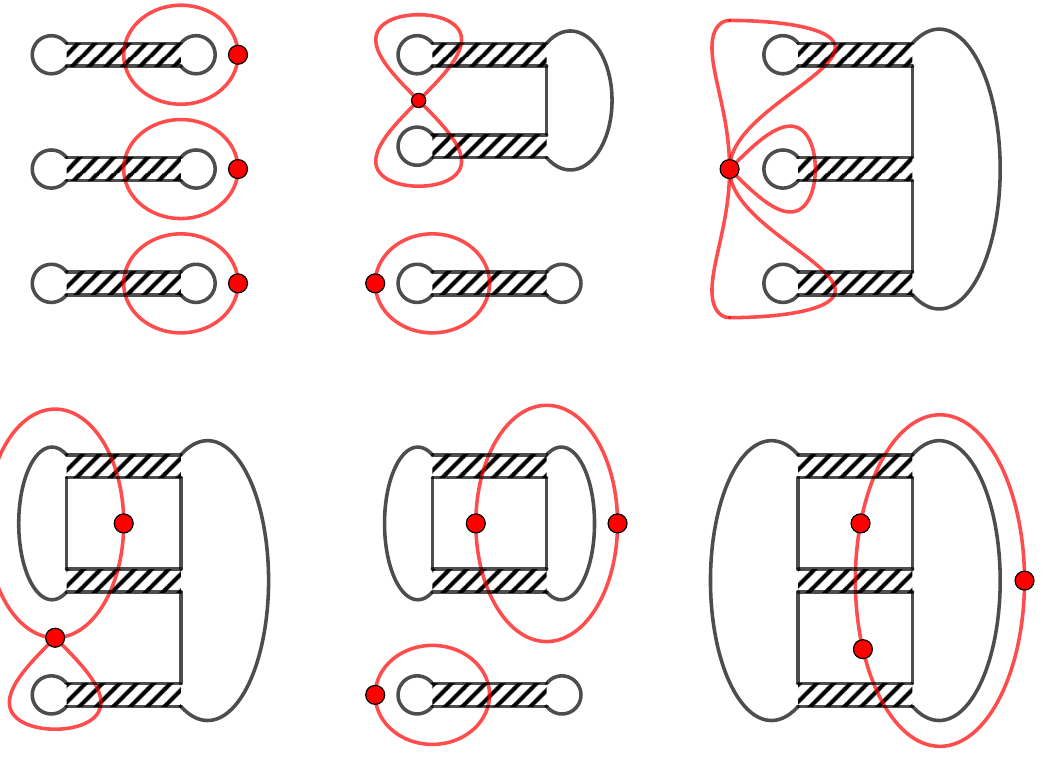
Figure 4 . Ribbon graphs (in black) and (cid:26) graphs (in red) for n = 3